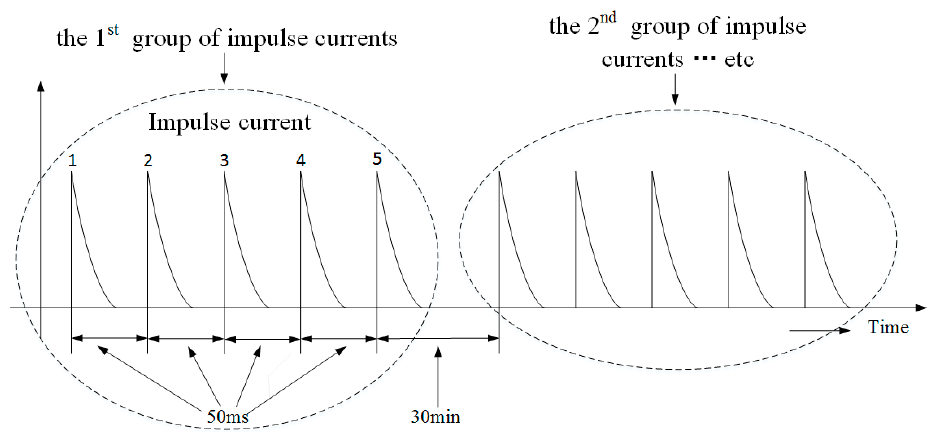
Figure 5. Groups of impulse currents applied to the ZnO varistors.